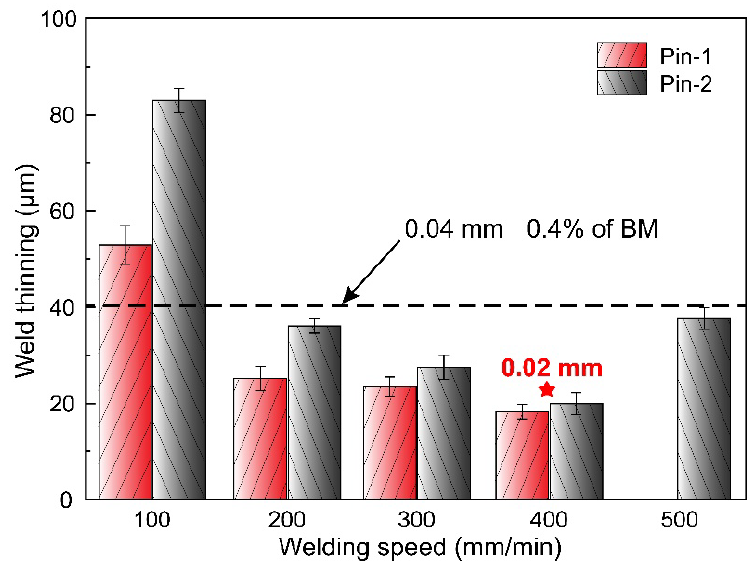
Figure 5. Weld thinning of joints at different welding speeds.